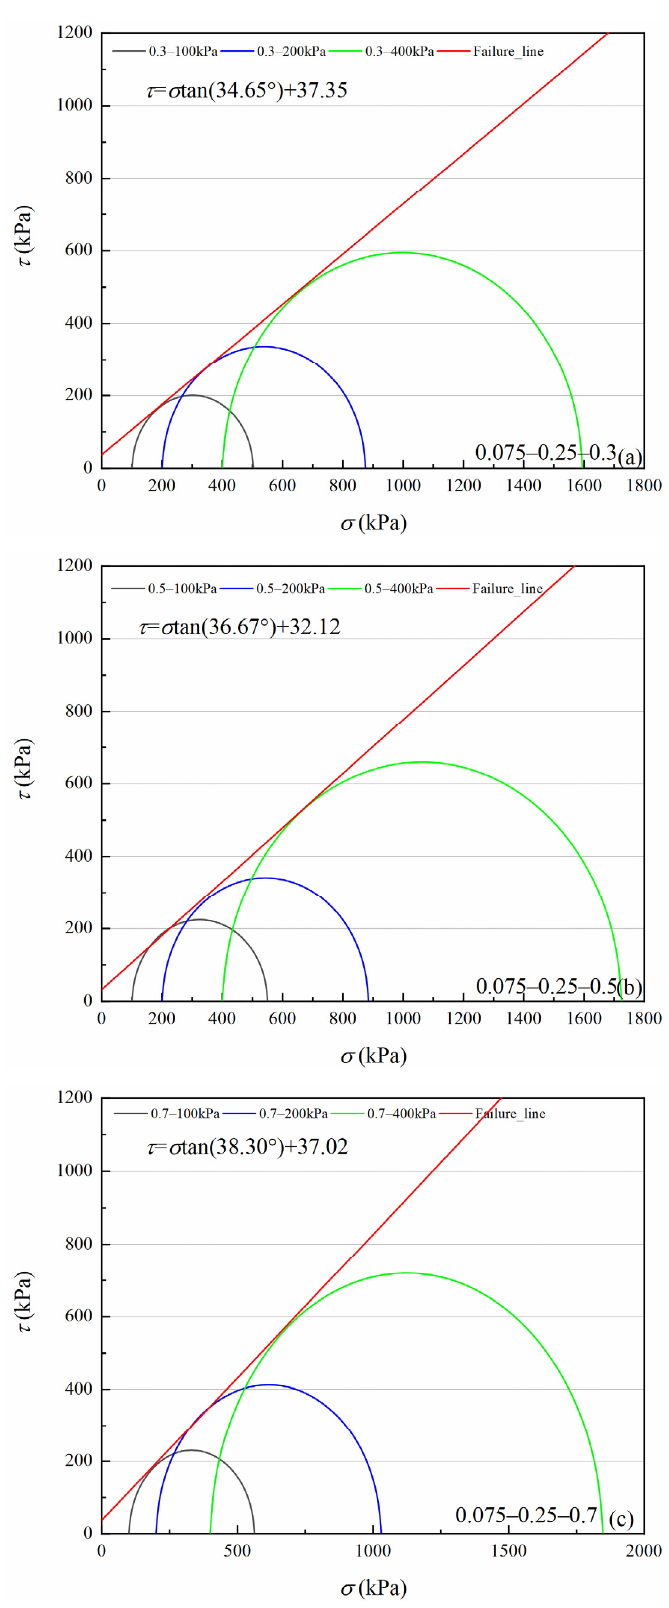
Figure 10. Shear strength envelopes of 0.075–0.25 mm particle groups volcanic soil with different relative density ( Dr ) under the peak state: ( a ) Dr = 0.3, ( b ) Dr = 0.5, ( c ) Dr = 0.7.